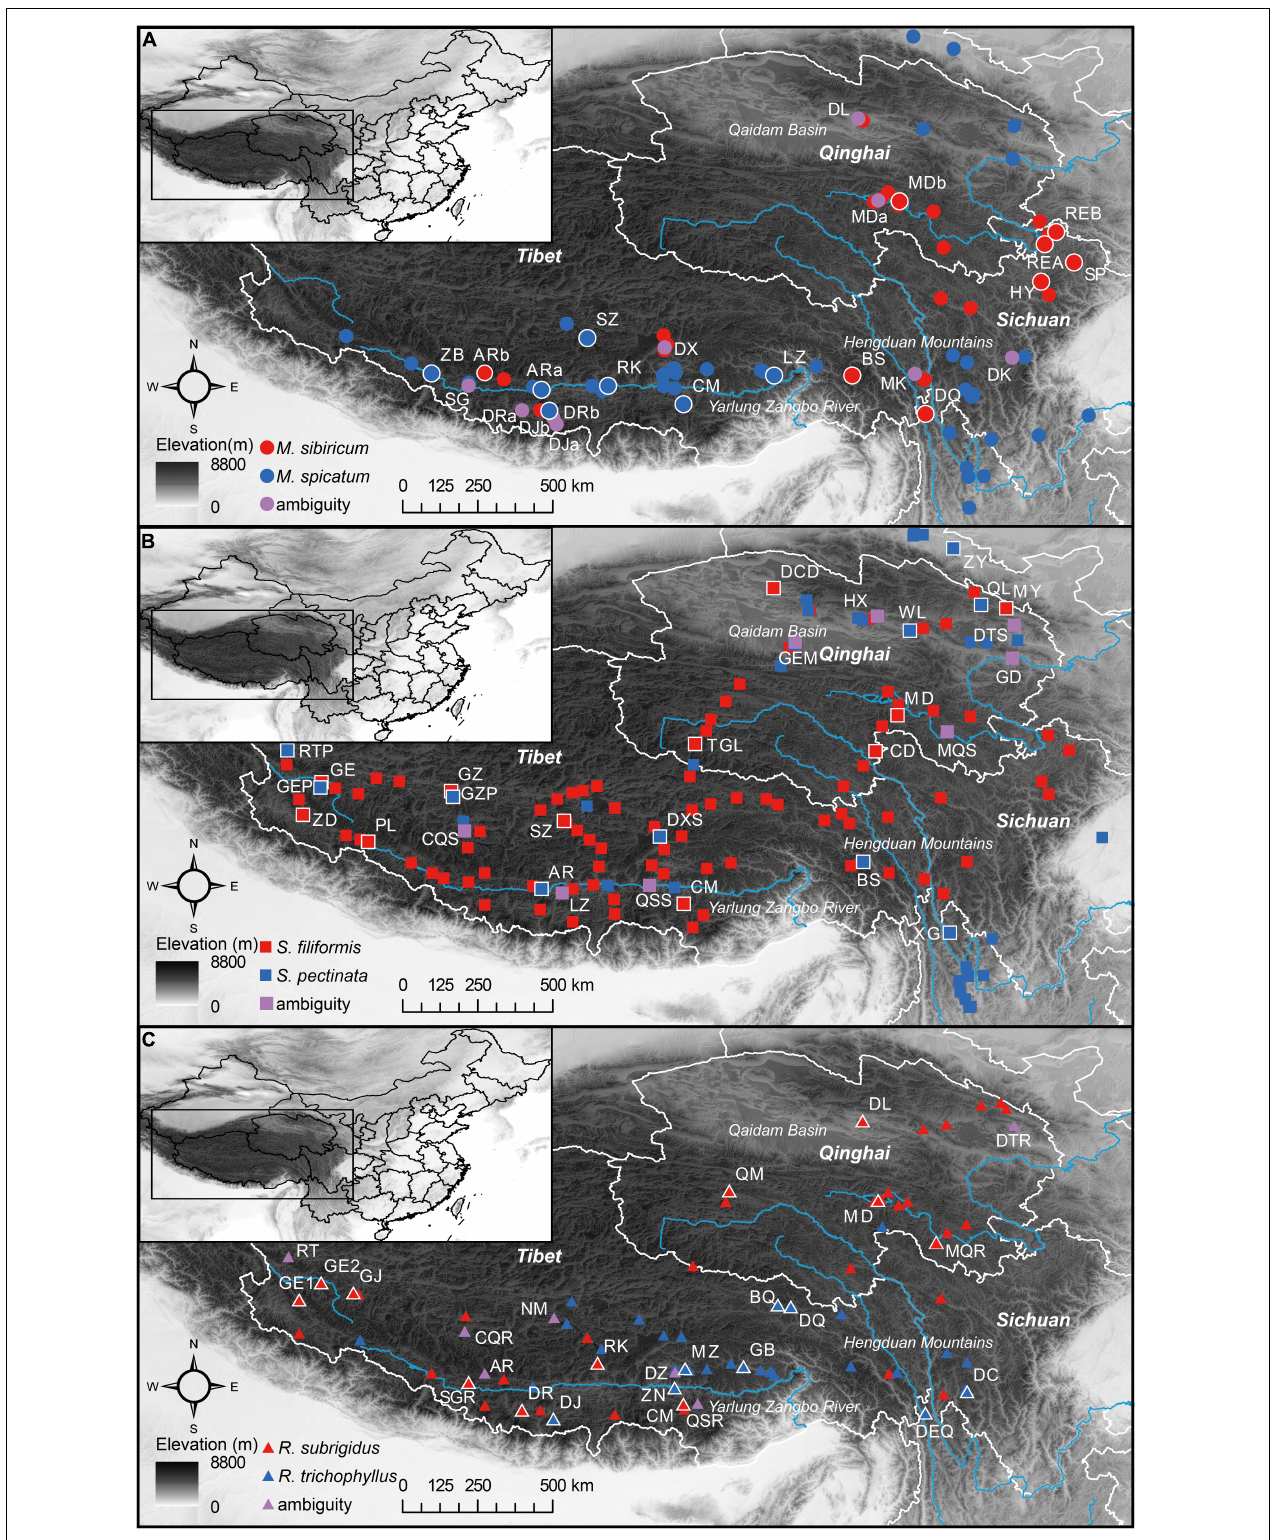
FIGURE 1 | Geographic distribution of each parental species [ (A) Myriophyllum , (B) Stuckenia , and (C) Ranunculus ] and morphologically ambiguous populations on the Qinghai-Tibetan Plateau. The pure populations used in molecular identification are labeled and outlined in white.